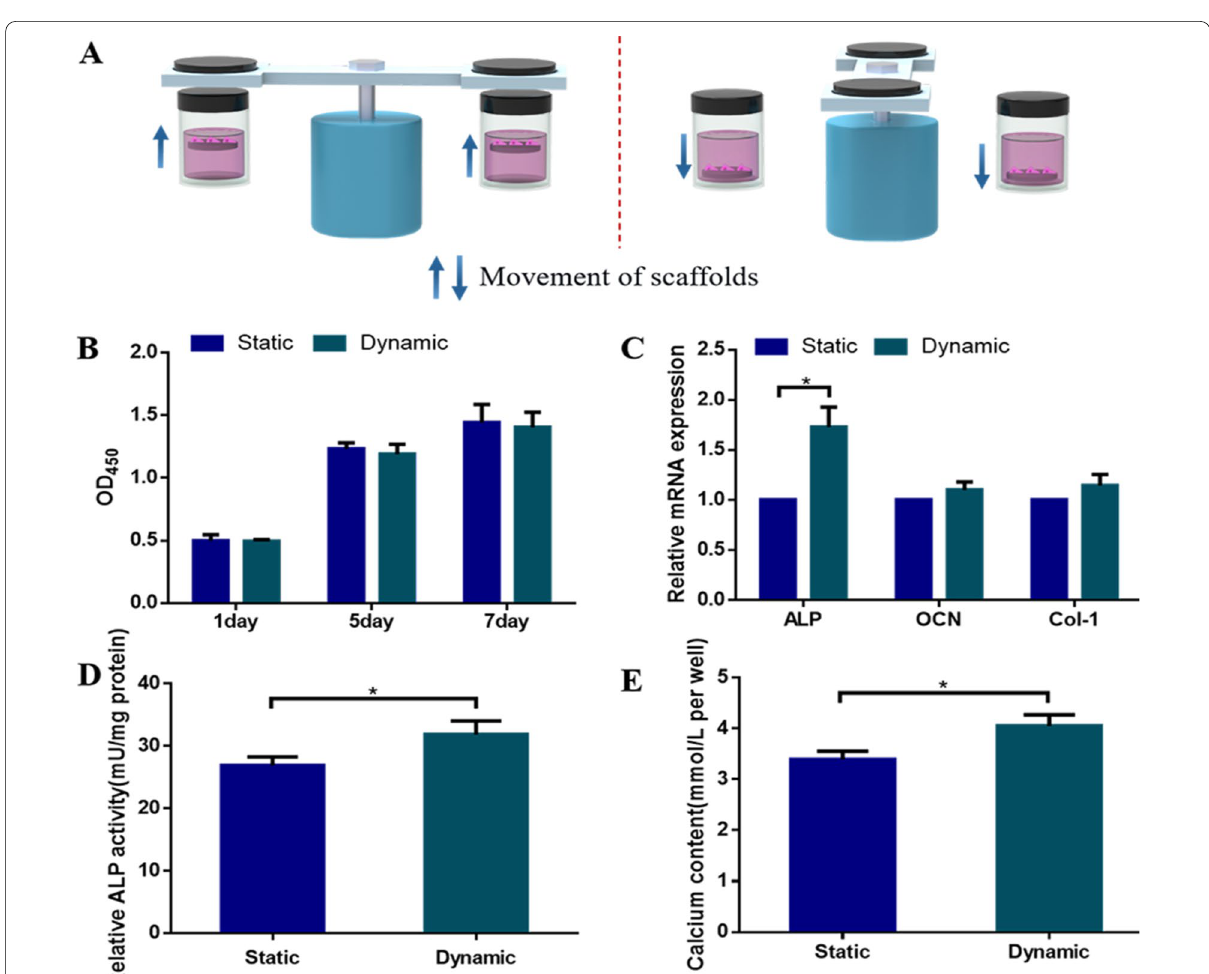
Fig. 8 Proliferation and differentiation of HMUSCs in dynamic and static cultures. A The working principle of the experimental set‑up. The magnetic scaffolds move up and down under the action of magnetic force and gravity. B The HUMSCs proliferation after seeding on the S1 scaffolds for 1, 5, and 7 days. C The quantitative evaluation of osteogenic‑related genes in HUMSCs cultured for 14 days. D Quantitative analysis of ALP activity in HUMSCs cultured for 7 days. E Calcium contents in HUMSCs cultured for 14